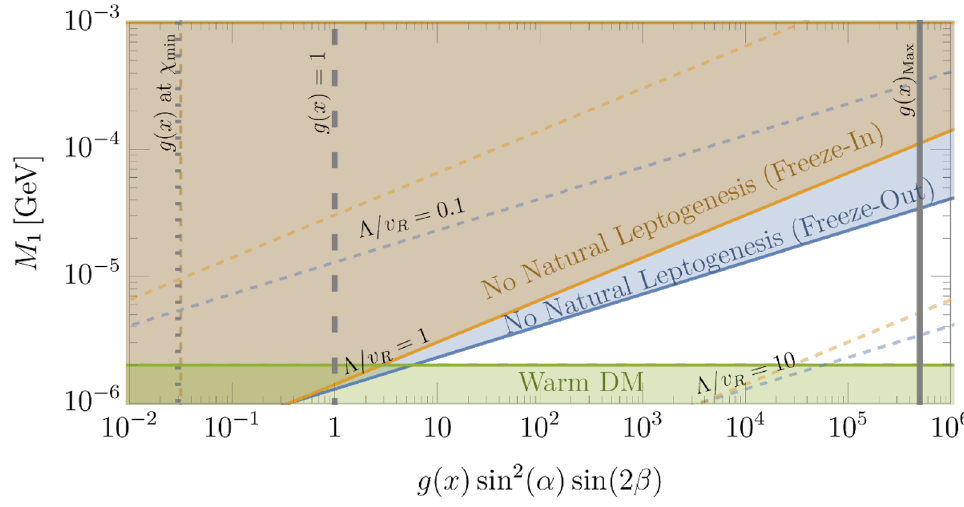
Figure 13 . Parameter space for simultaneous N 1 DM and N 2 leptogenesis without fine-tuning. In the ( blue , orange ) shaded regions, the observed baryon asymmetry from N 2 decay, in the (freeze- out, freeze-in) cosmology, requires y 33 so large that fine-tuning is needed for sufficient stability of N 1 , when Λ = v R . The upper and lower dashed blue and orange contours show the analagous exclusion regions for Λ /v R = 0 . 1 and Λ /v R = 10 , respectively. In the green shaded region, N 1 DM is too warm. In both freeze-out or freeze-in cosmologies, successful N 2 leptogenesis requires g ( x ) > 1 for Λ & v R ; the greater Λ /v R is, the more degenerate M 2 and M 3 must be to realize the observed baryon asymmetry. The vertical gray solid, dashed, and dotted lines show representative values of g ( x ) when M 2 and M 3 have the maximal natural degeneracy ( g ( x ) max , solid), when M 2 and M 3 are comparable ( g ( x ) = 1 , dashed), and when m ( ss ) and m (5) are as naturally degenerate 3 3 as can be ( g ( x ) at χ min ,